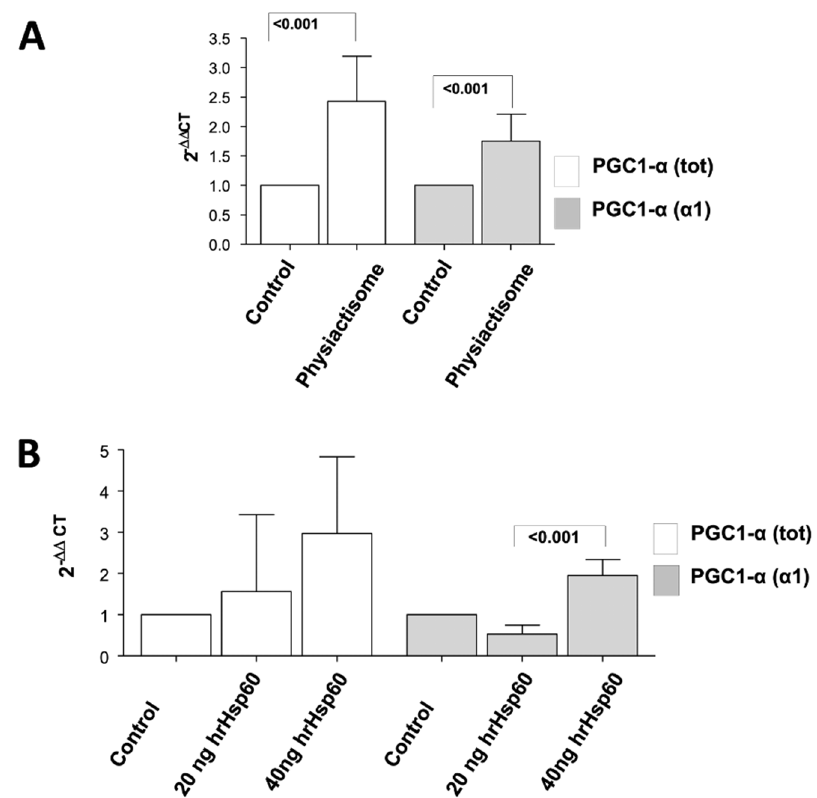
Figure 6. Bars show the transcript level expression of PGC1 α isoforms ( PGC1 α total ( α tot), isoform 1 ( α 1)) as revealed by real-time PCR (values are normalised to those of the reference genes). Fold change was calculated according to the Livak Method (2 −ΔΔ CT ) in C2C12 cell lines (naïve) treated with Physiactisome ( A ) or C2C12 cell lines (naïve) treated with recombinant human Hsp60 (hrHsp60, ( B )).